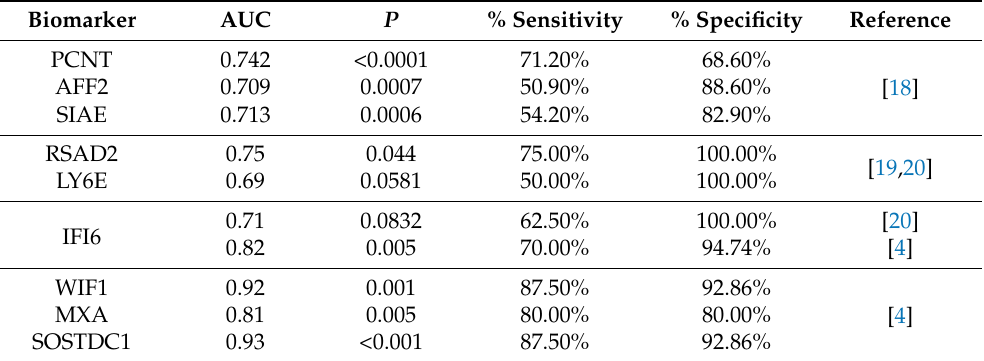
Table 2. Examples of biomarkers in literature with potential clinical use in